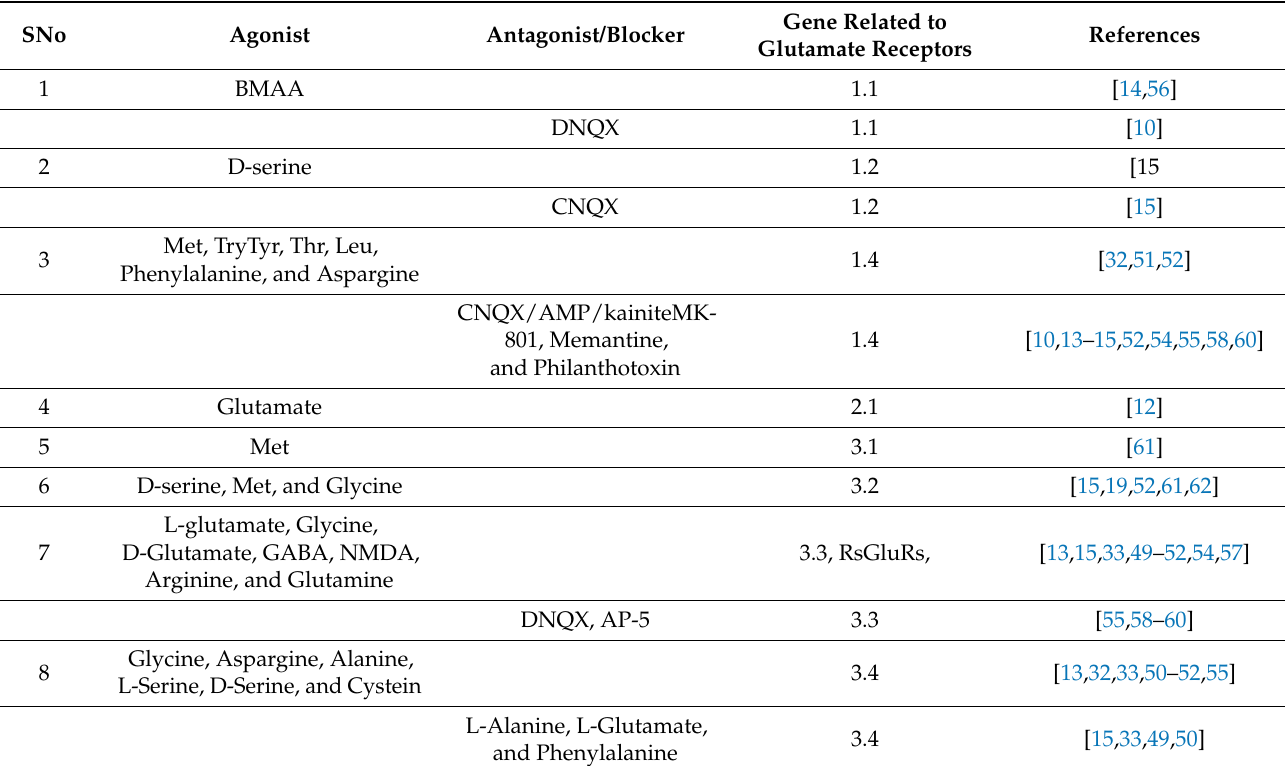
Table 1. List of different agonists, antagonists, or blockers that were used on AtGluRs